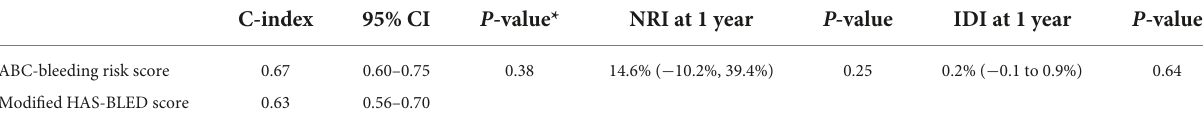
TABLE 3 Discrimination and reclassification analysis of the ABC-bleeding risk and the modified HAS-BLED scores.